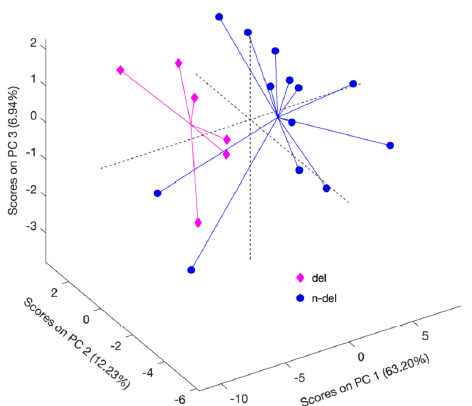
Figure 6. Three-dimensional principal component analysis of brain tumors with different 1p/19q co-deletion statuses. Autoscaling and logarithmic transformation were applied; del- 1p/19q co-deleted samples; n-del- 1p/19q non co-delated samples.